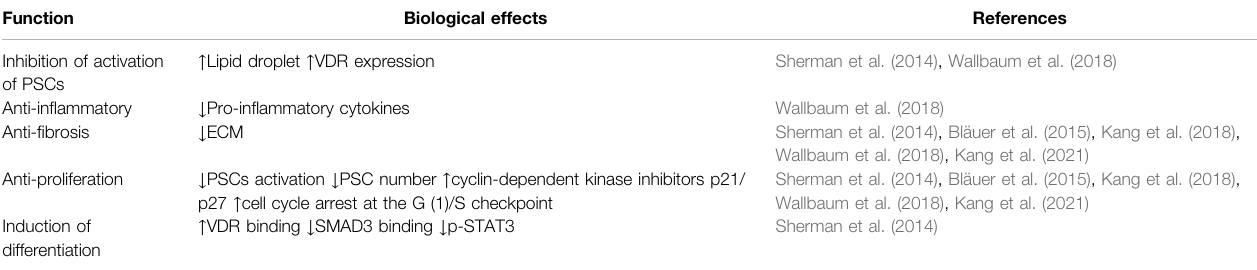
TABLE 2 | Summary on the role of vitamin D in CP from in vivo and in vitro studies. Function Biological effects